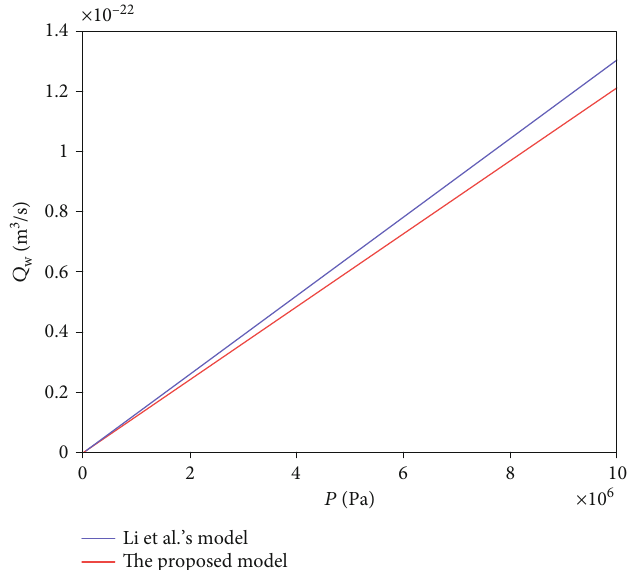
Figure 9: Comparison of water fl ow rate Q